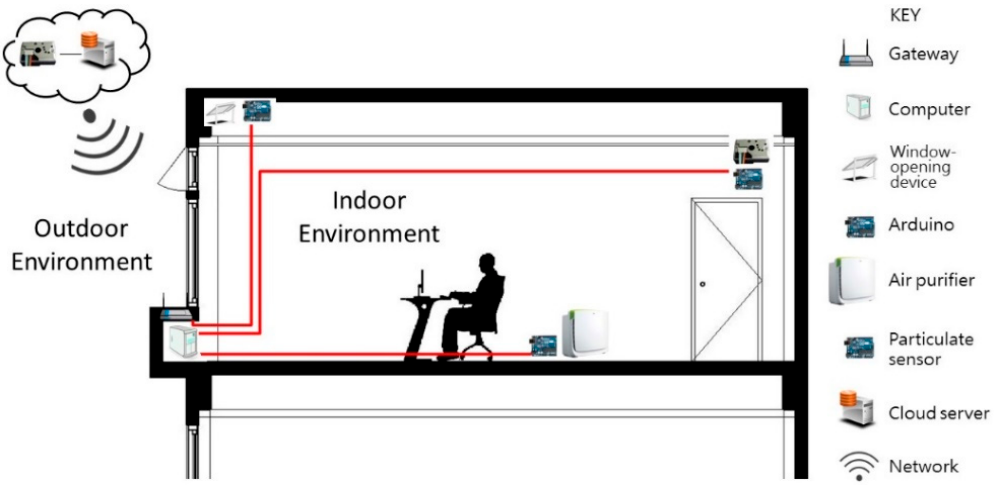
Figure 7. Schematic diagram of the environment.